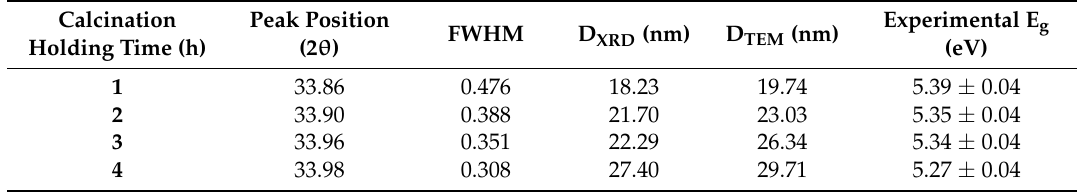
Table 3. Summary of the structural and optical features of the synthesized willemite NPs calcined at 900 ◦ C with different heat–treatment condition.